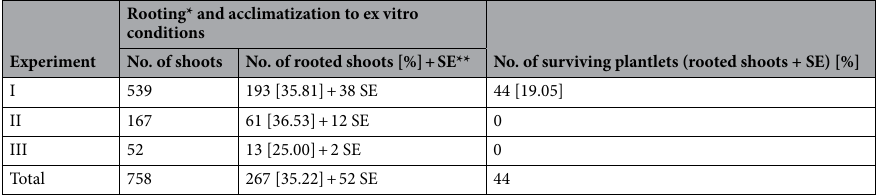
Table 3. Efficiency of rooting on ½ MS (2% saccharose) and acclimatization of micropropagated shoots of Pulsatilla patens and plants converted from somatic embryos (SE). *Single shoots or cluster of